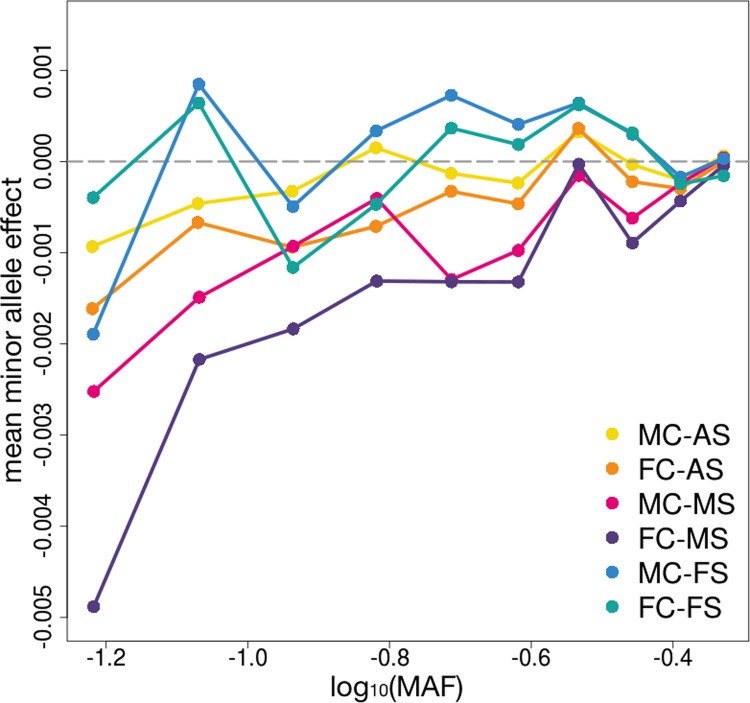
Selection signatures of facial attractiveness.SNPs with MAF between 0.05 and 0.5 were grouped into 10 equally-sized bins based on MAF quantiles. For SNPs in each bin, average MAF was calculated shown on the x-axis, while the average minor allele effects are shown on the y-axis.